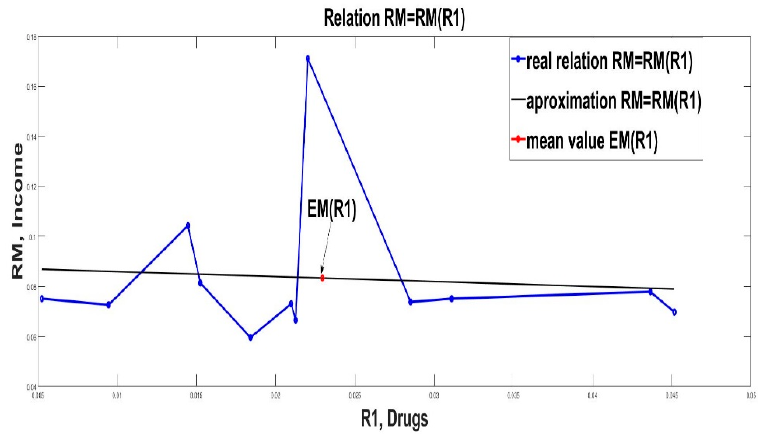
Figure 2. Linear approximation of income R M from R 1 (drugs) .